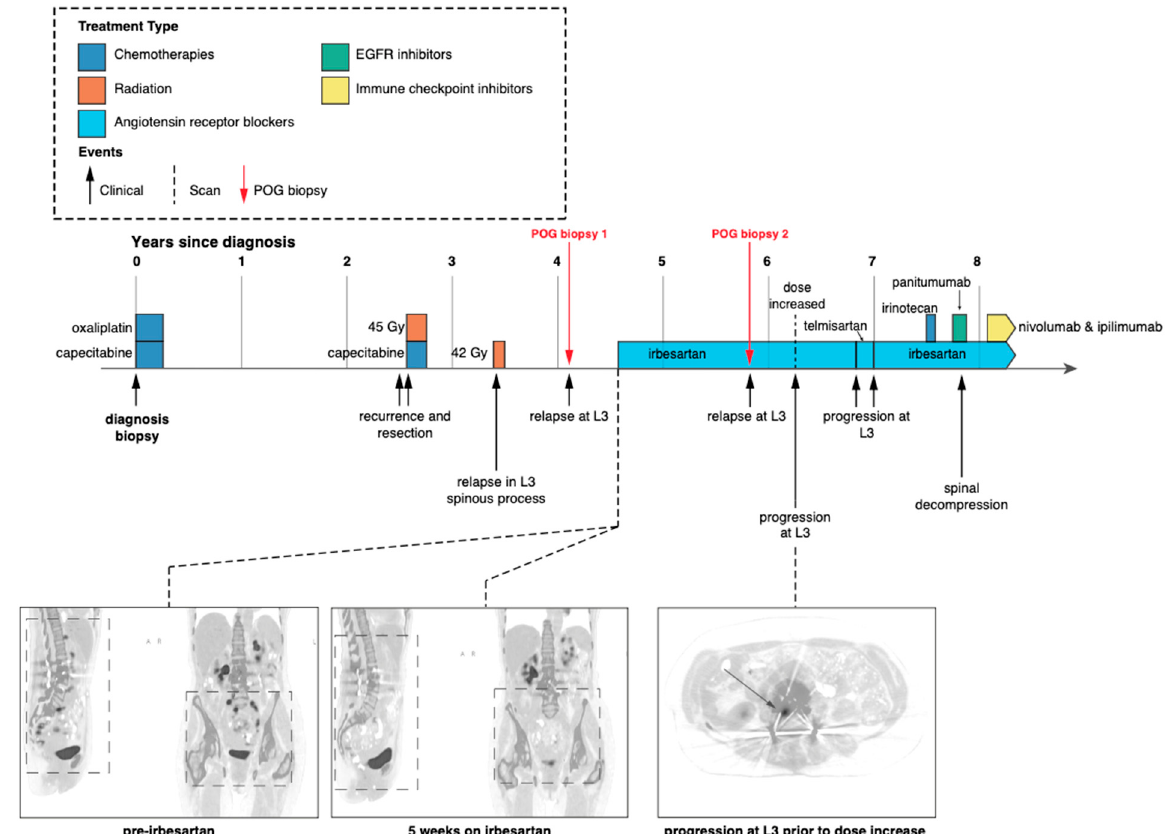
Figure 1. Patient clinical and treatment history. Timeline depicting patient treatment, follow-up and imaging since initial diagnosis [9]. Red arrows indicate biopsies for the POG program described in this study. Both POG biopsies were taken from the same location at the base of the spine.